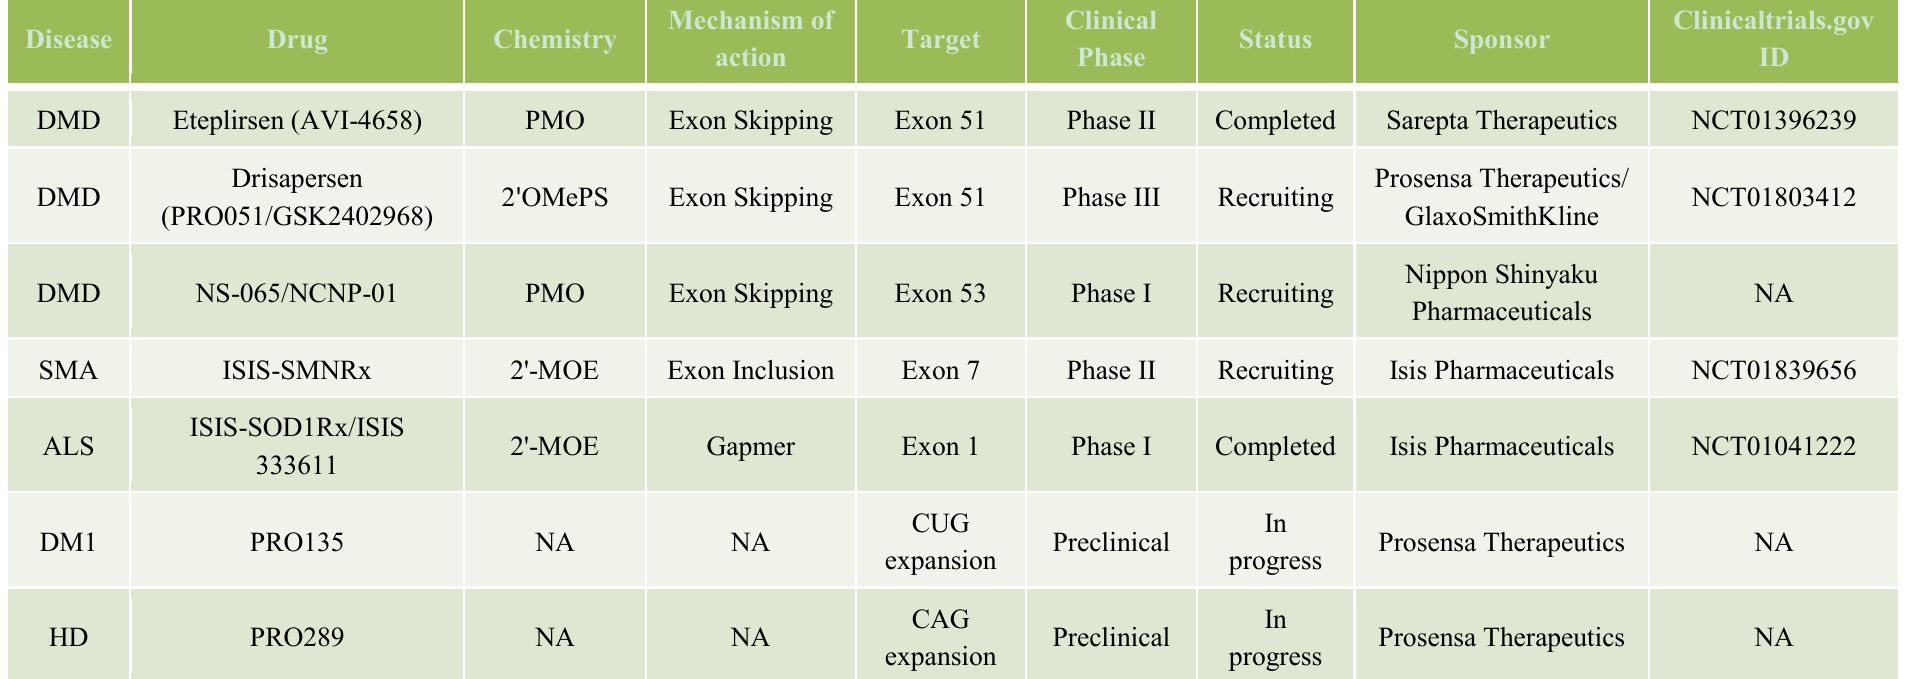
Table 1. Current clinical trial status of antisense drugs for use in neurodegenerative and neuromuscular disorders.